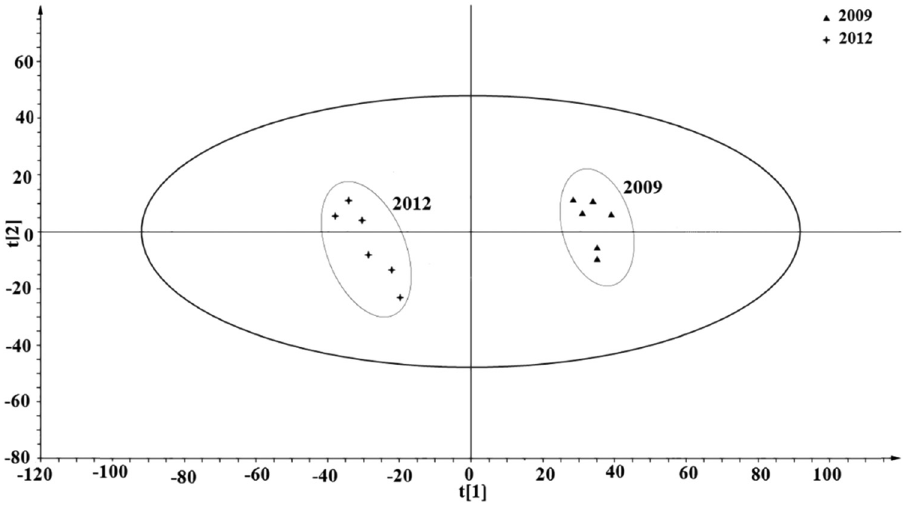
Figure 9: PLS - DA score plot chart from 1 H NMR spectra of 2009 and 2012 vintage Cabernet Sauvignon wines.